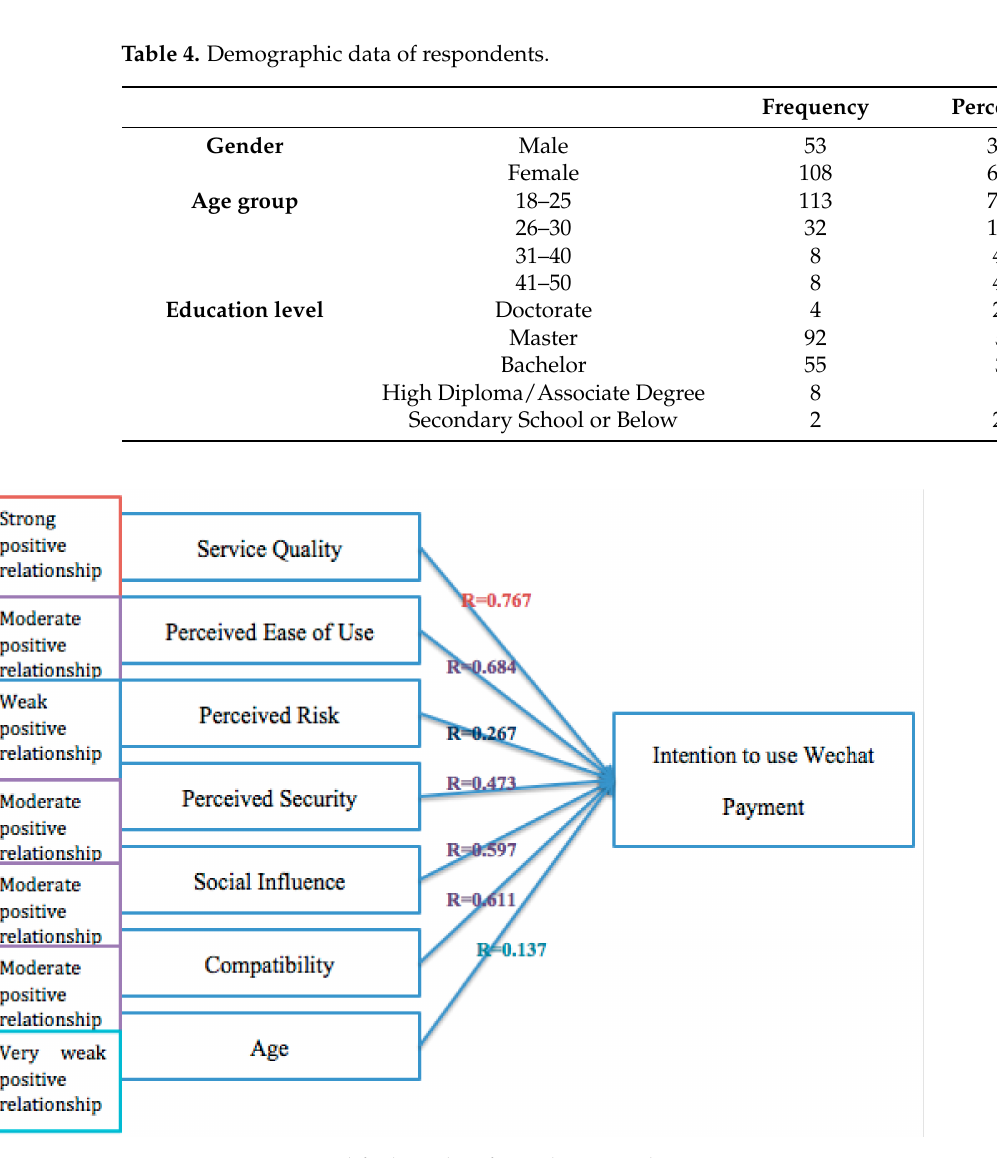
Figure 2. Simplified results of correlation